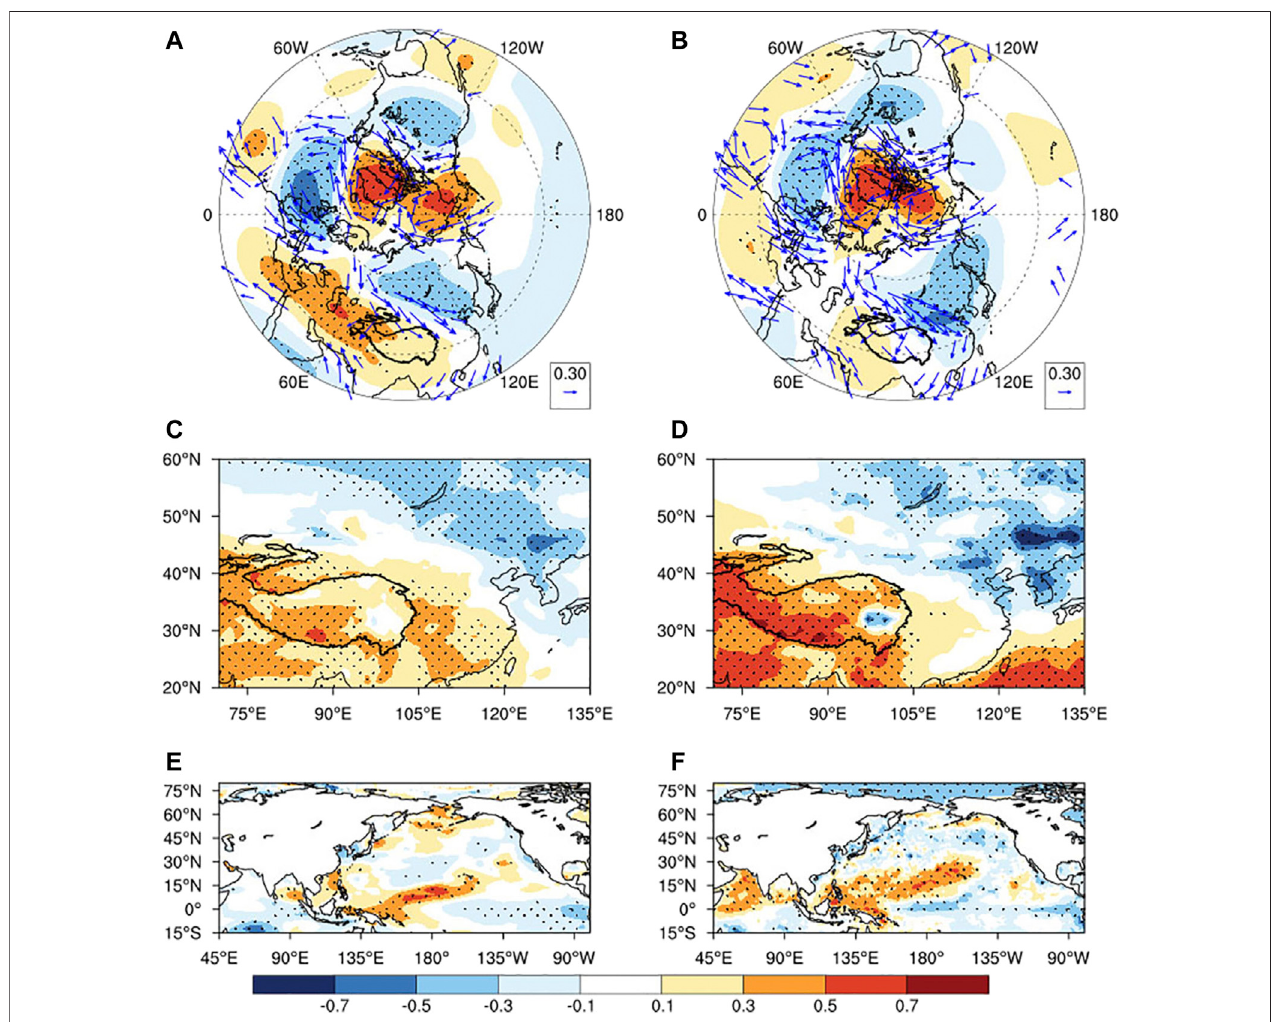
FIGURE4|(A,C) Correlationcoef fi cientsbetweenthePC1ofsnowcoverand (A) 500-hPageopotentialheight(shade)and500-hPawind(vector), (C) landsurface temperature in winter (B,D) . As in (A,C) but for the PC1 of summer CHDEs. Black dots indicate values signi fi cant at the 95% con fi dence level. A positive correlation for zonal or meridional wind component is denoted by an eastward or poleward arrow, respectively.